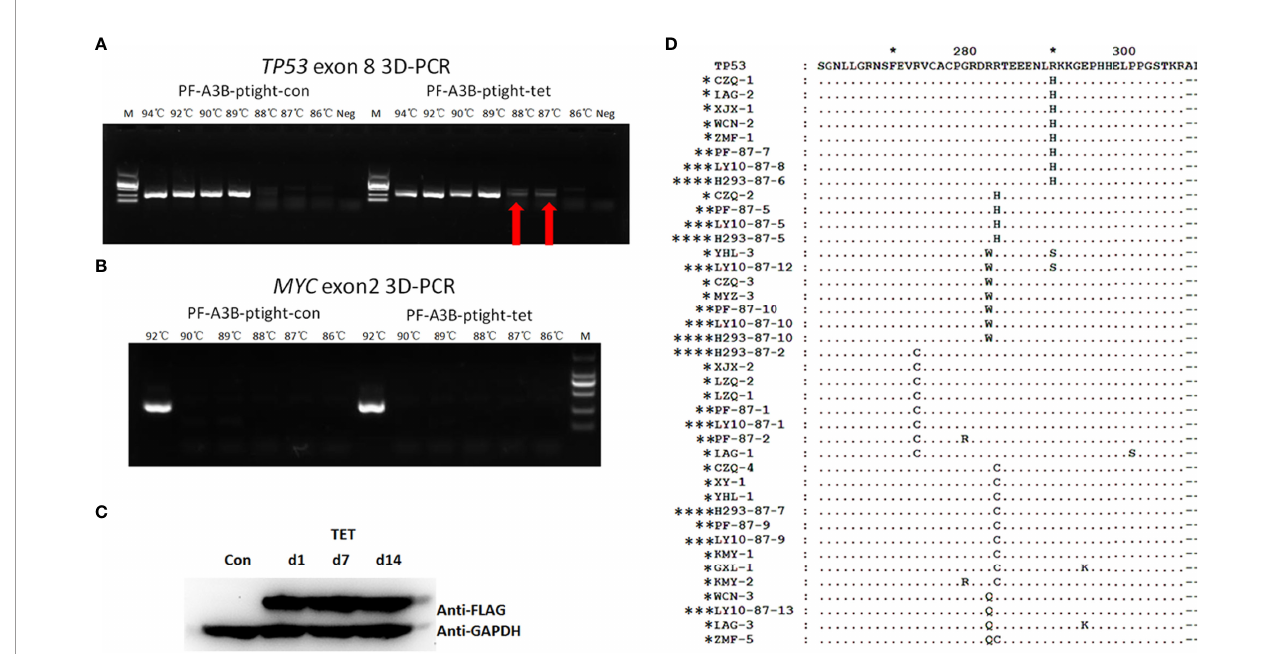
FIGURE 6 | APOBEC3B induces TP53 exon 8 mutations in vitro . (A) 3D-PCR ampli fi cation of TP53 exon 8 in APOBEC3B-inducible Pfeiffer cells (right) and control cells (left). Red arrows indicate DNA fragments that ampli fi ed at a denaturing temperature of 88°C and 87°C. PCR products were separated by agarose gel electrophoresis (top). APOBEC3B- fl ag expression was con fi rmed by Western blotting using an anti- fl ag antibody (bottom). Con, cell lysis before induction with doxycycline; d1, cell lysis after induction with doxycycline for 1 day; d7, cell lysis after induction with doxycycline for 7 days; d14, cell lysis after induction with doxycycline for 14 days; M, DNA ladder marker; Neg, negative control; PF, Pfeiffer. Denaturation temperatures in 3D-PCR ranged from 92°C to 87°C. (B) 3D-PCR ampli fi cation of MYC exon 2 in APOBEC3B-inducible Pfeiffer cells. PCR products were separated by agarose gel electrophoresis (top). Expression of APOBEC3B- fl ag was con fi rmed by Western blotting using an anti- fl ag antibody (bottom). (C) Detection of APOBEC3B- fl ag by Western blotting in APOBEC3B-inducible cells. (D) Comparison of in vitro APOBEC3B-induced p53 mutants with R/R DLBCL samples. P53 sequences were analyzed using Clustal and Genedoc software. *DLBCL patients. **APOBEC3B-inducible Pfeiffer cells. ***APOBEC3B-inducible OCI-LY10 cells. **** APOBEC3B-inducible HEK293